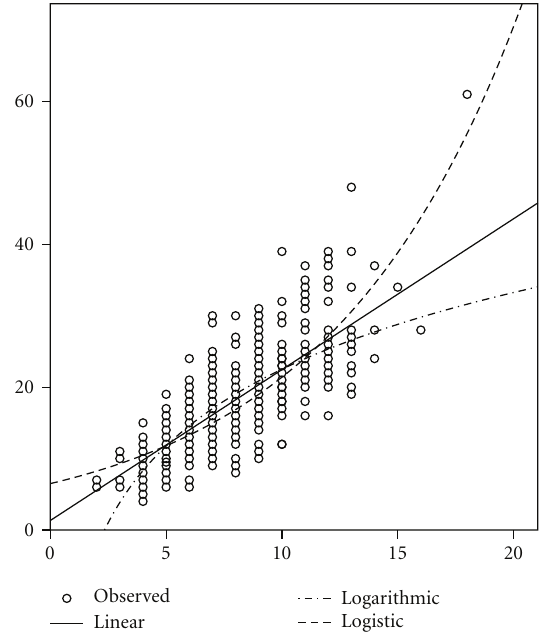
Figure 1: Correlation of MOI with Body Mass Index-based FRAX 10-year major osteoporosis fracture risk in the pooled fracture cohort ( N = 500) ( R 2 = 0 . 54, F = 596 ). ( x = MOI, y = FRAX).